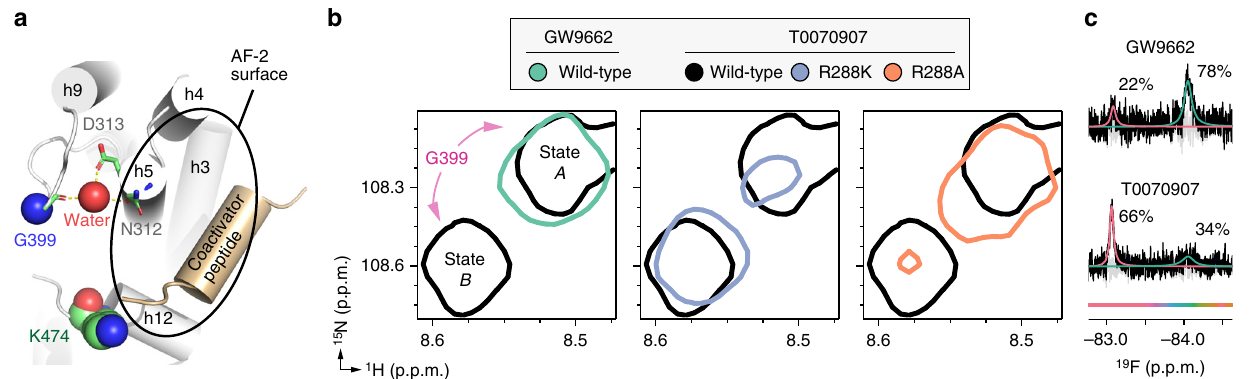
Fig. 6 T0070907 populates a shared conformation with GW9662 and a unique conformation. a Structural location of G399, which is connected to the AF- 2 coregulator interaction surface via water-mediated hydrogen bonds to N312 and D313 but does not directly interact with a coregulator peptide bound to the PPAR γ LBD (PDB code 2PRG). b Snapshot overlay of [ 1 H, 15 N]-TROSY-HSQC NMR spectra of 15 N-labeled PPAR γ LBD (wild-type or R288 mutants) bound to GW9662 or T0070907 shows that the single GW9662-bound G399 peak has similar chemical shift values to one of the two T0070907-bound G399 peaks (state A) whereas state B is uniquely populated by T0070907. The T0070907-bound R288K mutant PPAR γ LBD, but not T0070907-bound R288A mutant PPAR γ LBD, signi fi cantly populates the unique conformation. c Deconvoluted 19 F NMR spectra of PPAR γ LBD labeled with BTFA on helix 12 and covalently bound to GW9662 or T0070907